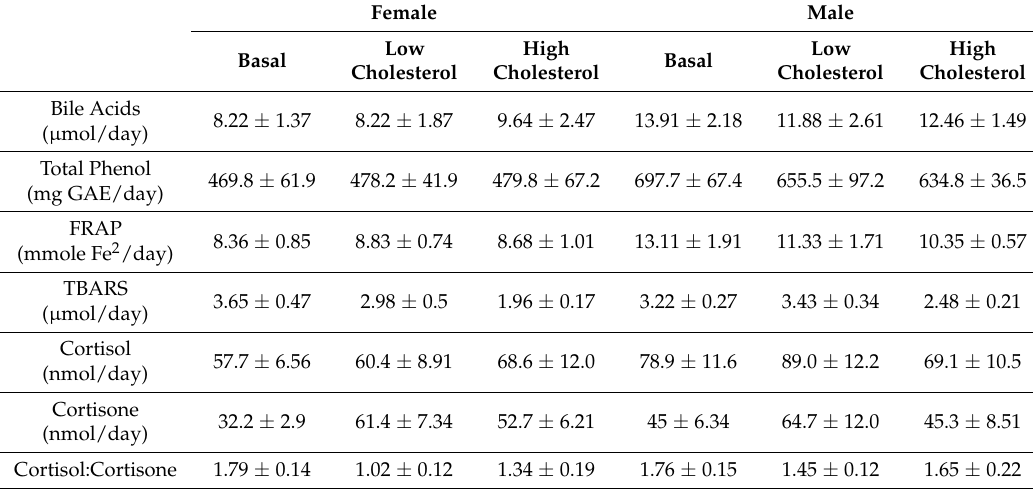
Table 3. Analysis of bile acids, glucocorticoids and oxidative stress markers in 24 h urine samples collected on basal, low-cholesterol, and high-cholesterol days (mean ± SD). Female Male Low High Low Basal Basal Cholesterol Cholesterol